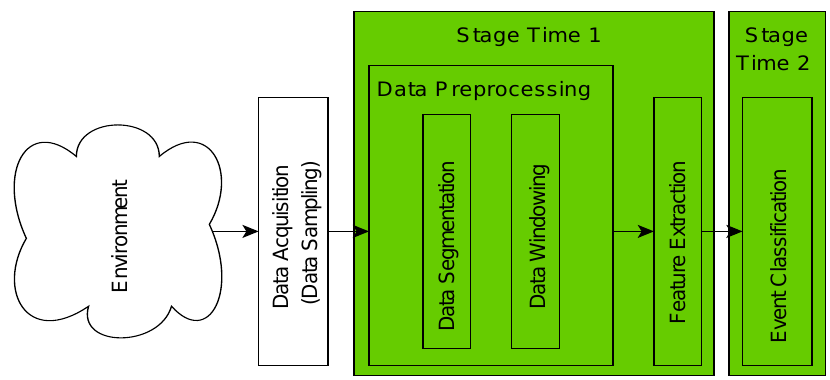
Figure 12. Timing factor for computational